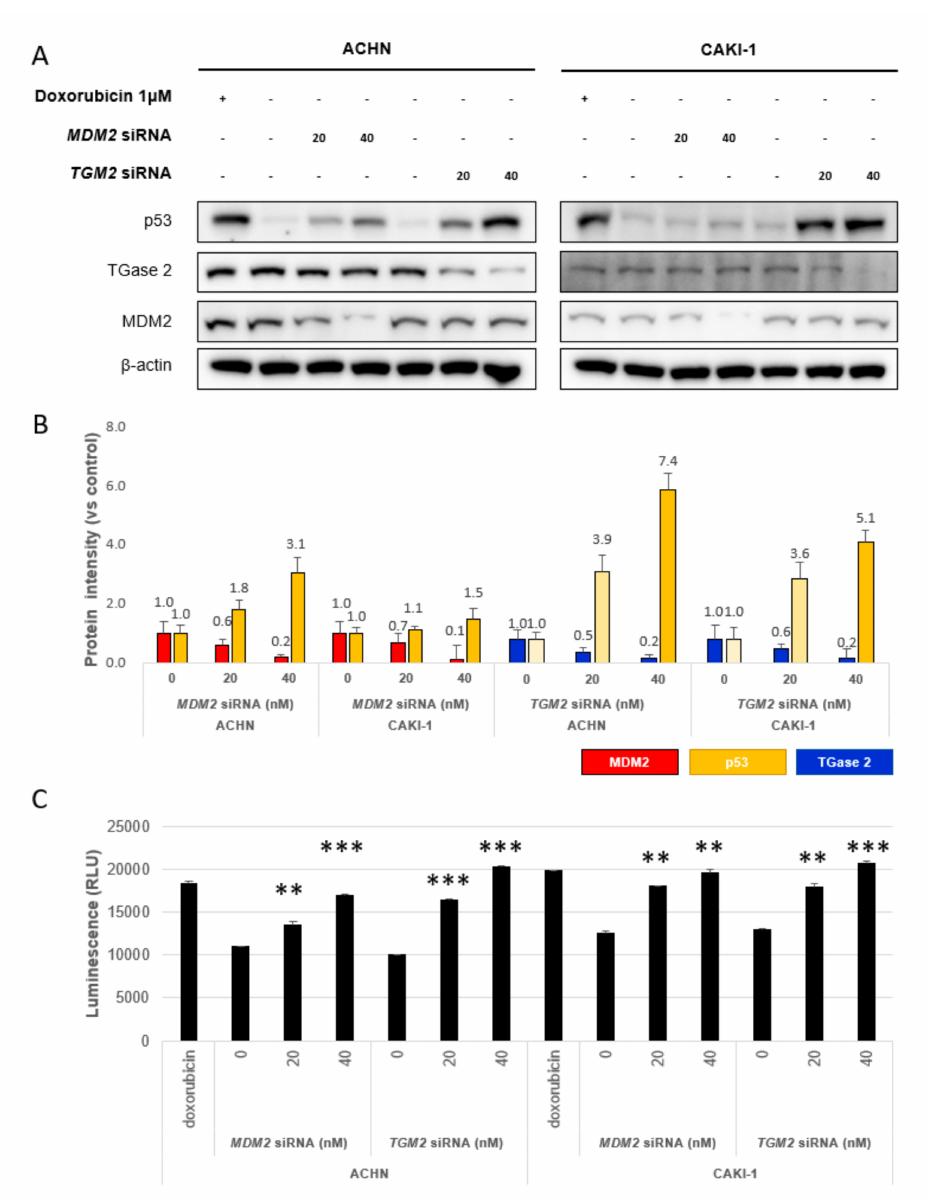
Figure 1. Transglutaminase 2 (TGase 2) and Mouse double minute 2 homolog (MDM2) destabilize p53 in renal cell carcinoma (RCC) under normoxic conditions. ( A ) ACHN (left) and CAKI-1 (right) cells were transfected for 24 h with siRNA targeting TGM2 or MDM2 . Doxorubicin (1 µ M) was used as a positive control. ( B ) Image J analysis of western blots in A. ( C ) Apoptosis assay to assess siTGM2 or siMDM2 silencing, as monitored by RealTime-Glo ™ Annexin V under the same conditions as in A. Cumulative data from three independent experiments are shown (mean ± SD; n = 3). ** p < 0.01 and *** p <